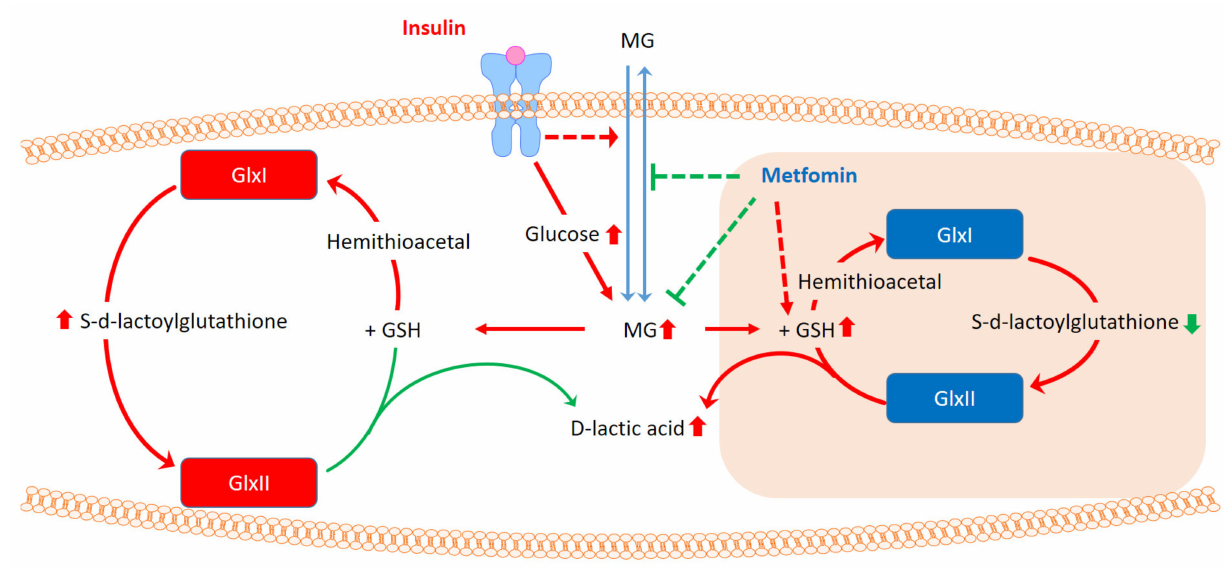
Figure 8. The coordinated effects of insulin and metformin on the glyoxalase system for maintaining intracellular concentra- tions of